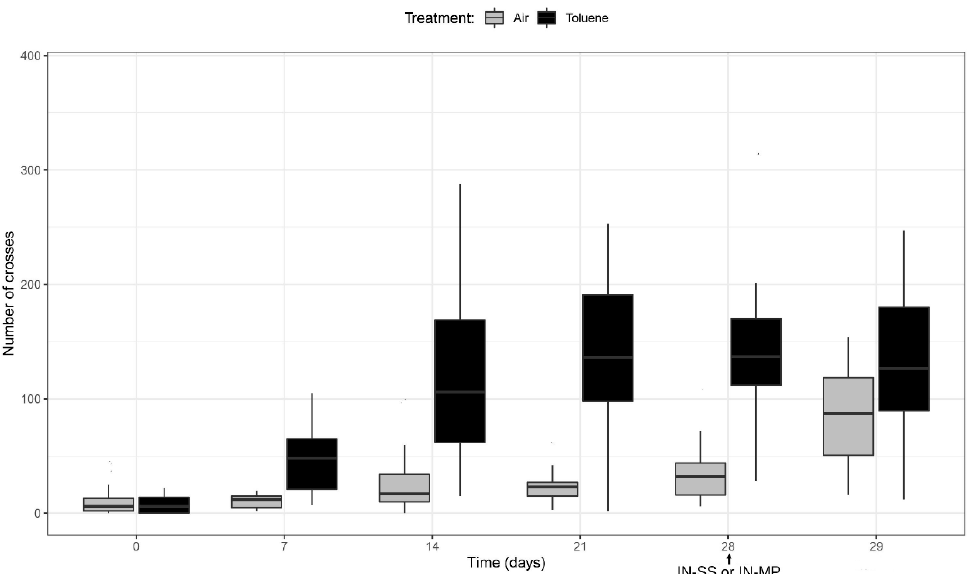
Figure 6. Mean ± SD of the number of crosses performed by 68 mice, half treated with air and the other half with toluene for 28 days. A group of 30 mice were then treated with one dose of IN-MP (200 mg/kg) and the locomotor activity was registered 24 h later. Values were compared by a T-student test.